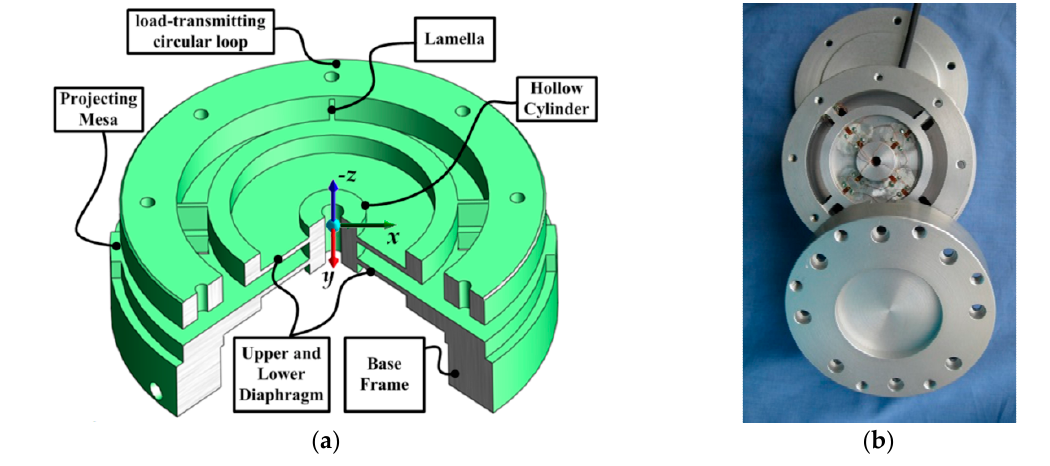
Figure 2. Six-axis strain gauge cutting force sensing system. ( a ) Sketch of the elastic element structure; ( b ) Fabricated prototype of the proposed sensor system.